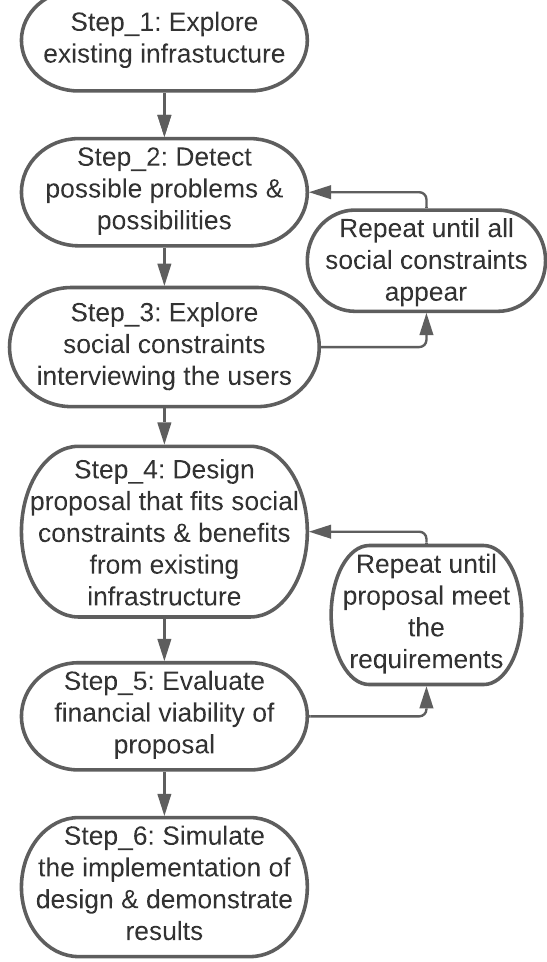
Figure 1. Methodology overview of the